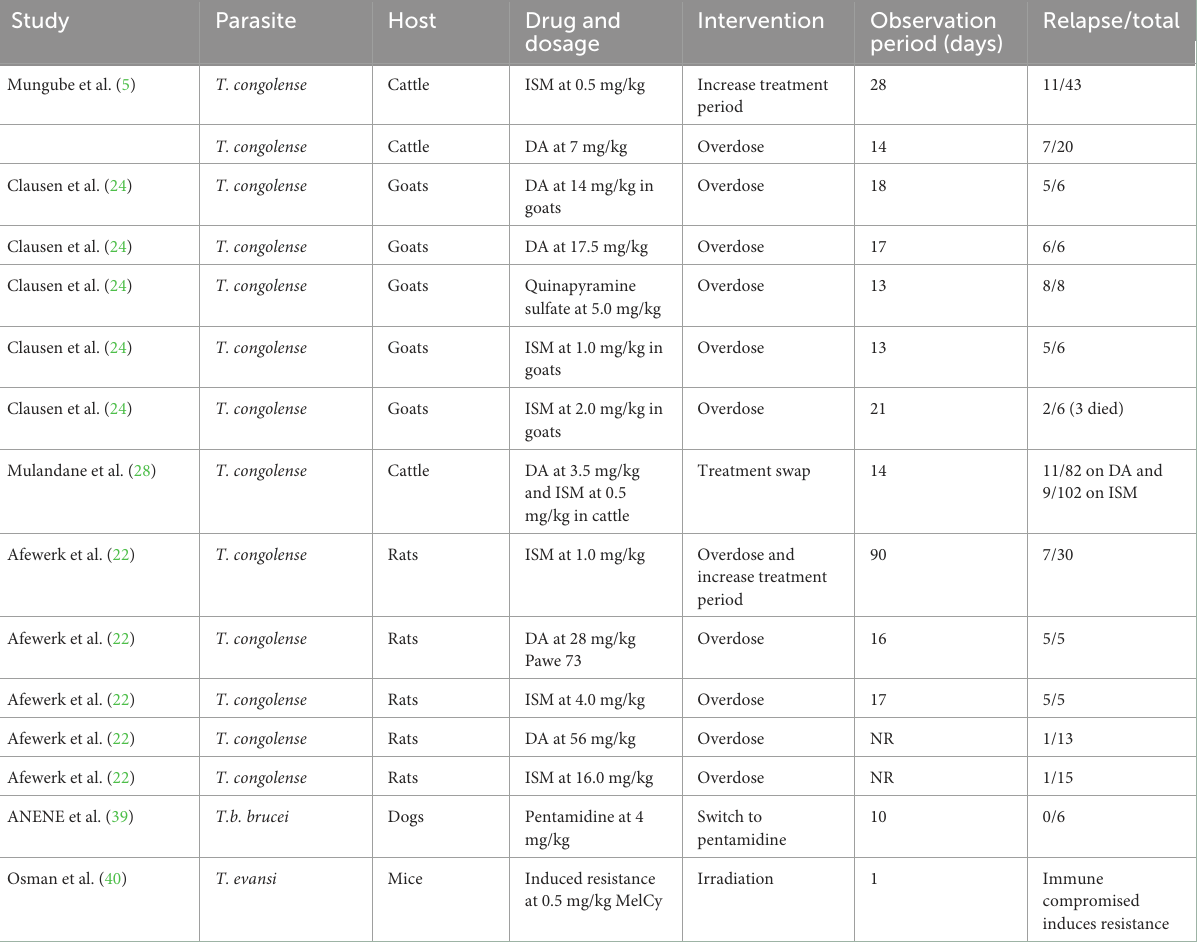
TABLE 5 Interventions to address trypanocide resistance in preclinical studies with dosages administered using different experimental models.